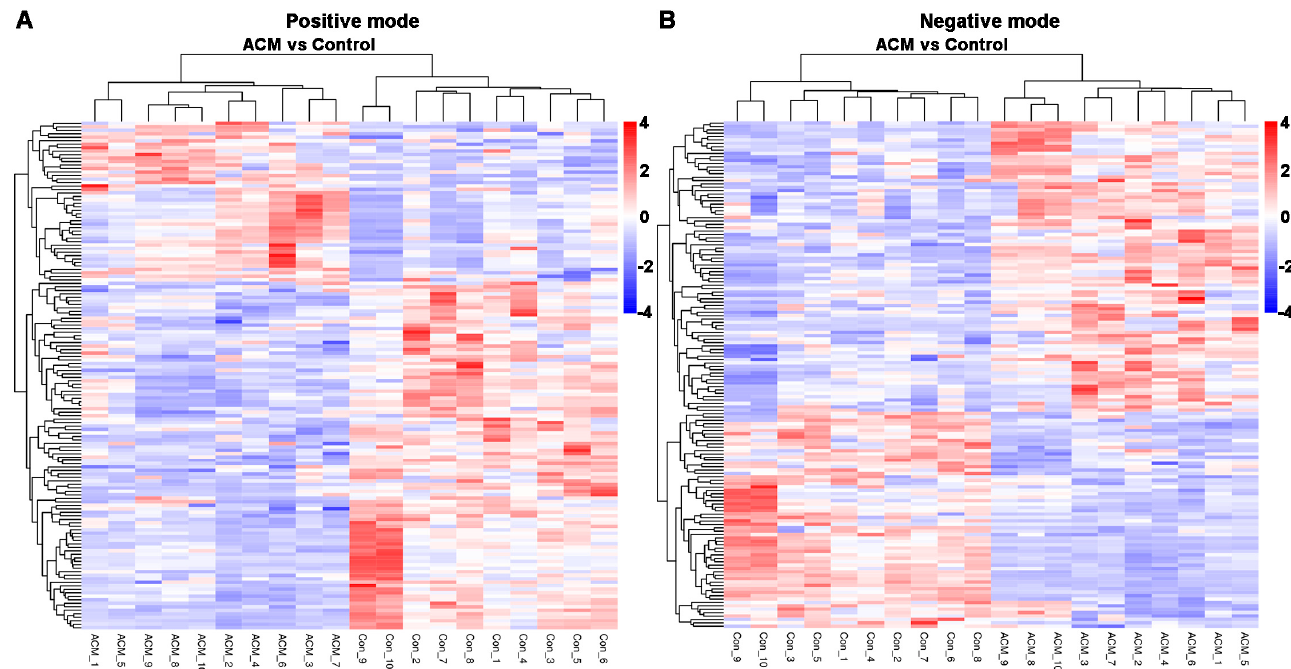
Figure 5. Volcano plots of myocardial metabolomics data between the control and ACM groups. ( A ) Positive mode; ( B ) negative mode. Red represents upregulated metabolites, green represents downregulated metabolites, and gray repre- sents metabolites with no difference between the two groups. The variable importance in projection (VIP) values represent the most important metabolites obtained in the PLS-DA model.